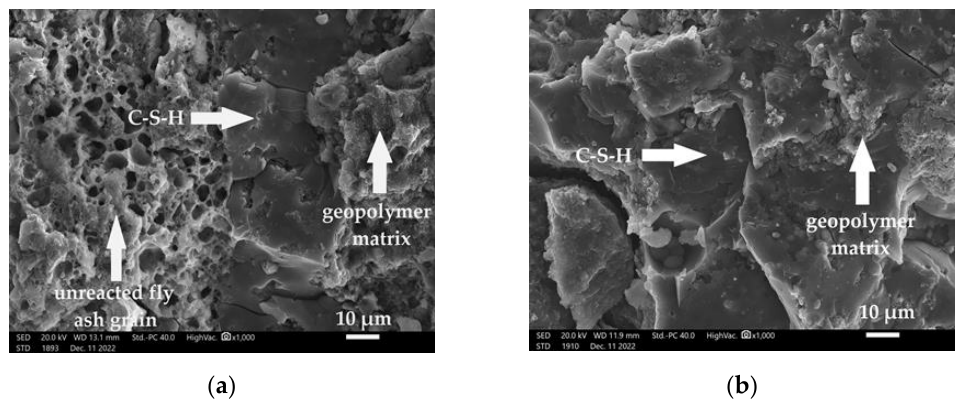
Figure 3. Microstructure of reference geopolymers in magnifications 1000×: ( a ) 10R, ( b ) 14R. In Figure 3a, the inconsistent structure of the porous material can be